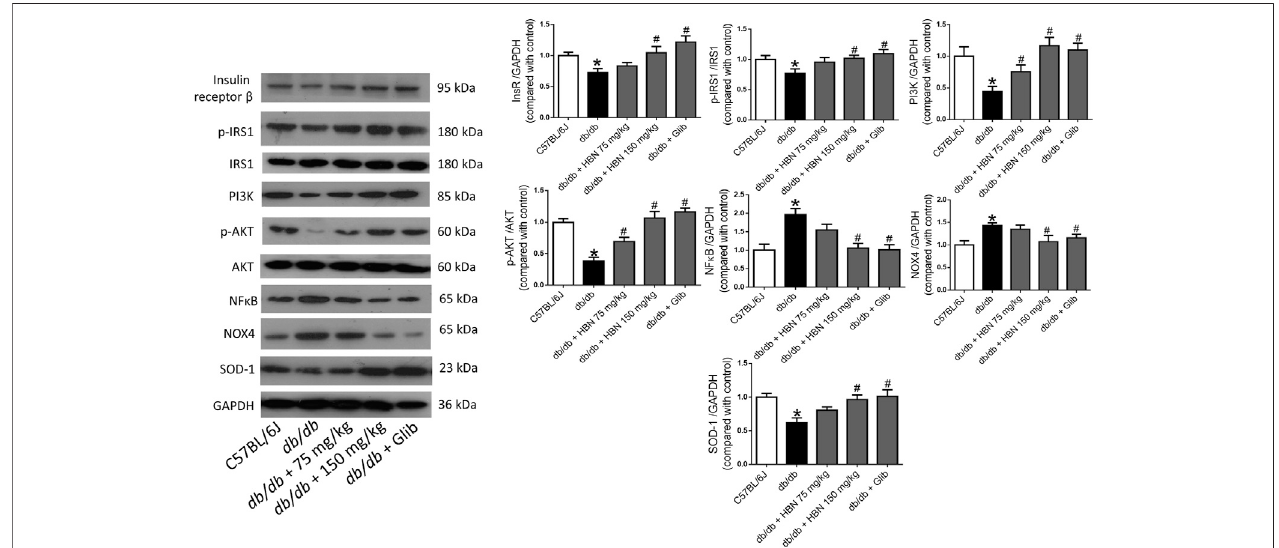
FIGURE5| EffectsofHBNonhepaticinsulinsignaling,in fl ammationandoxidativestress.Westernblotandquantitativedatashowingtheproteinexpressioninliver of C57BJ/L6 mice and db/db mice after treatment with HBN (75 and 150 mg/kg) and glibenclamide (1 mg/kg). Results are mean ± SEM of six experiments. * p < 0.05 compared to C57BL/6J mice, # p < 0.05 compared to db/db mice.